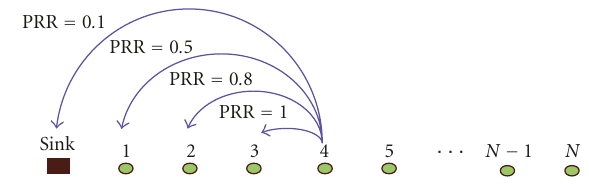
Figure 6: Illustration of the linear